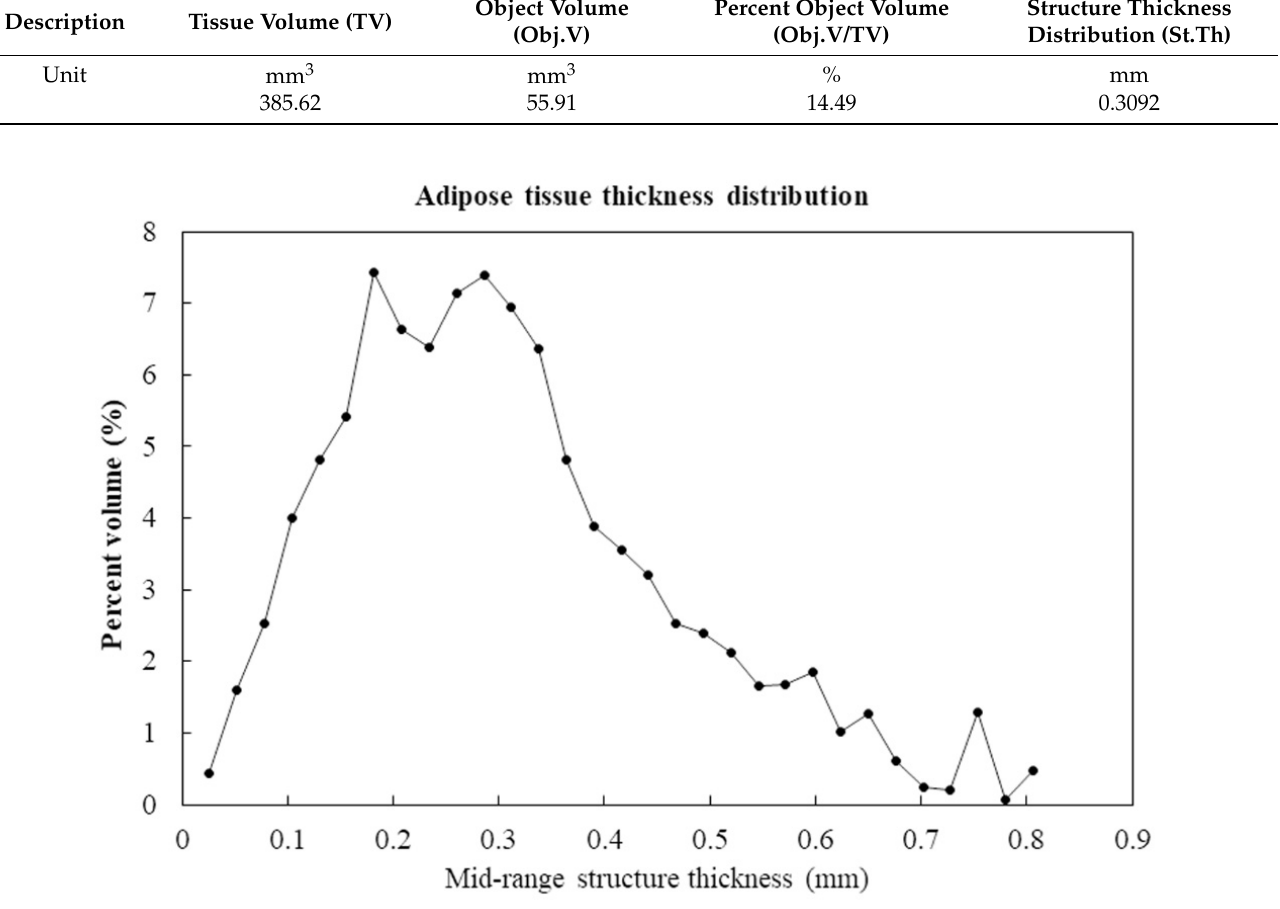
Figure 12. Distribution of trunk adipose tissue thickness.